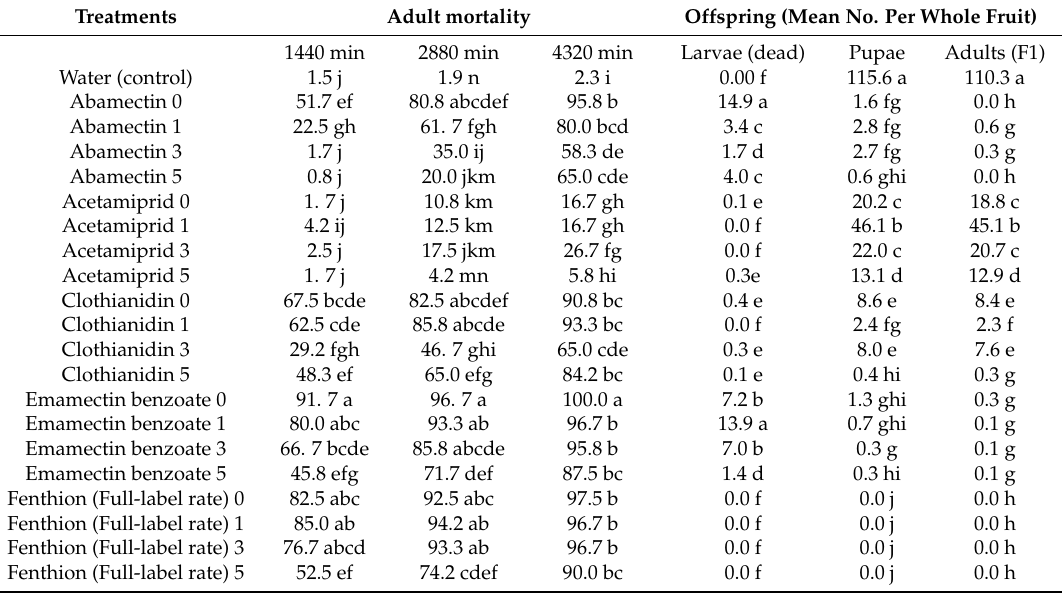
Table 5. The mortality of adult Bactrocera tryoni , exposed to stone fruit dipped in insecticide and aged for 0, 1, 3, or 5 days and then allowed to oviposit, and the resulting offspring (bioassay